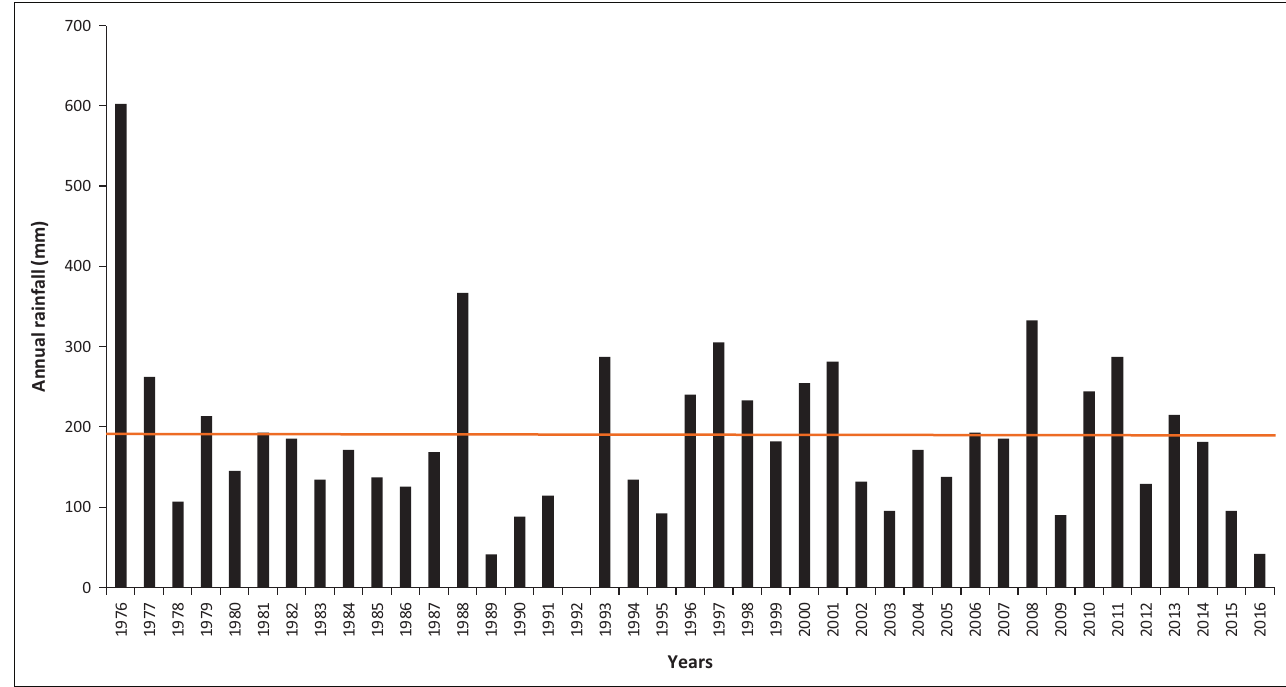
FIGURE 2: Total annual rainfall (January to December) at Nossob Rest Camp from 1976 until 2016. The orange line represents the mean annual rainfall of 194